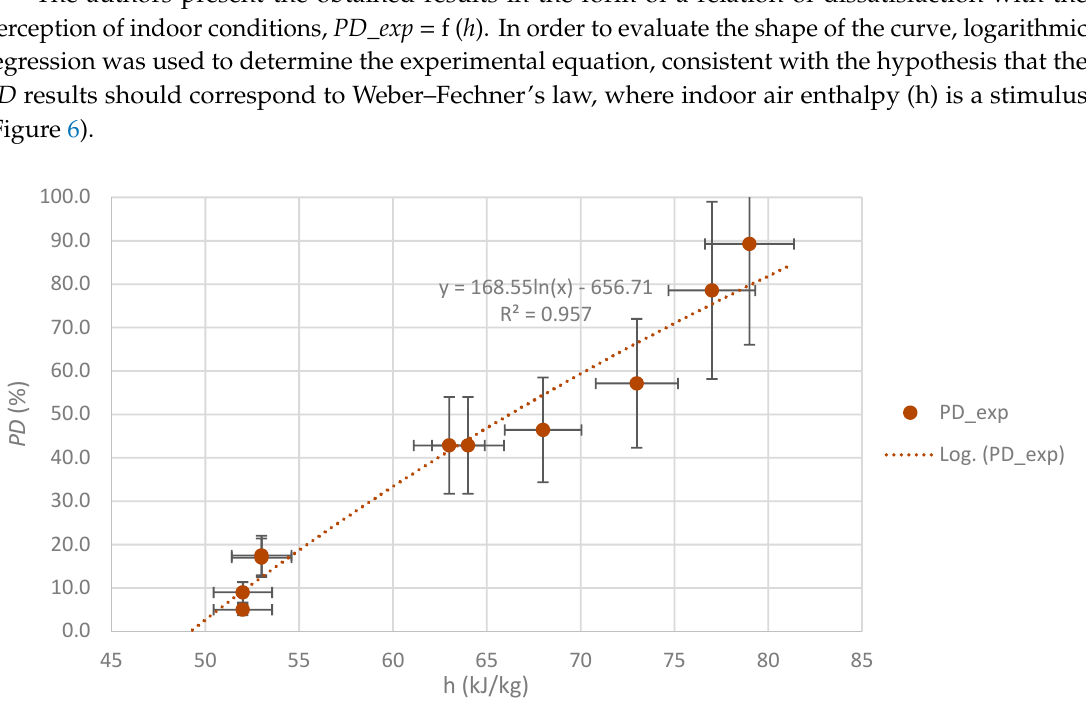
Figure 6. Percent of dissatisfied (subjects) in enthalpy function ( PD_exp ), results of experimental research and regression line (ln.( PD_exp )) under the following assumptions: air speed < 0.1 m / s, 0.6